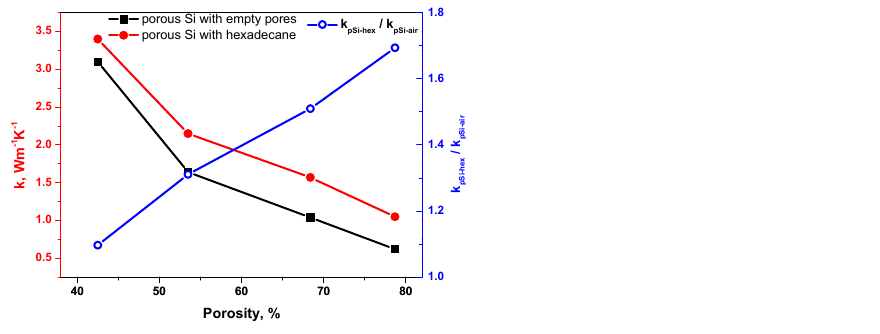
Figure 4. Porosity dependent thermal conductivity of porous Si layers without and with hexadecane in pores.